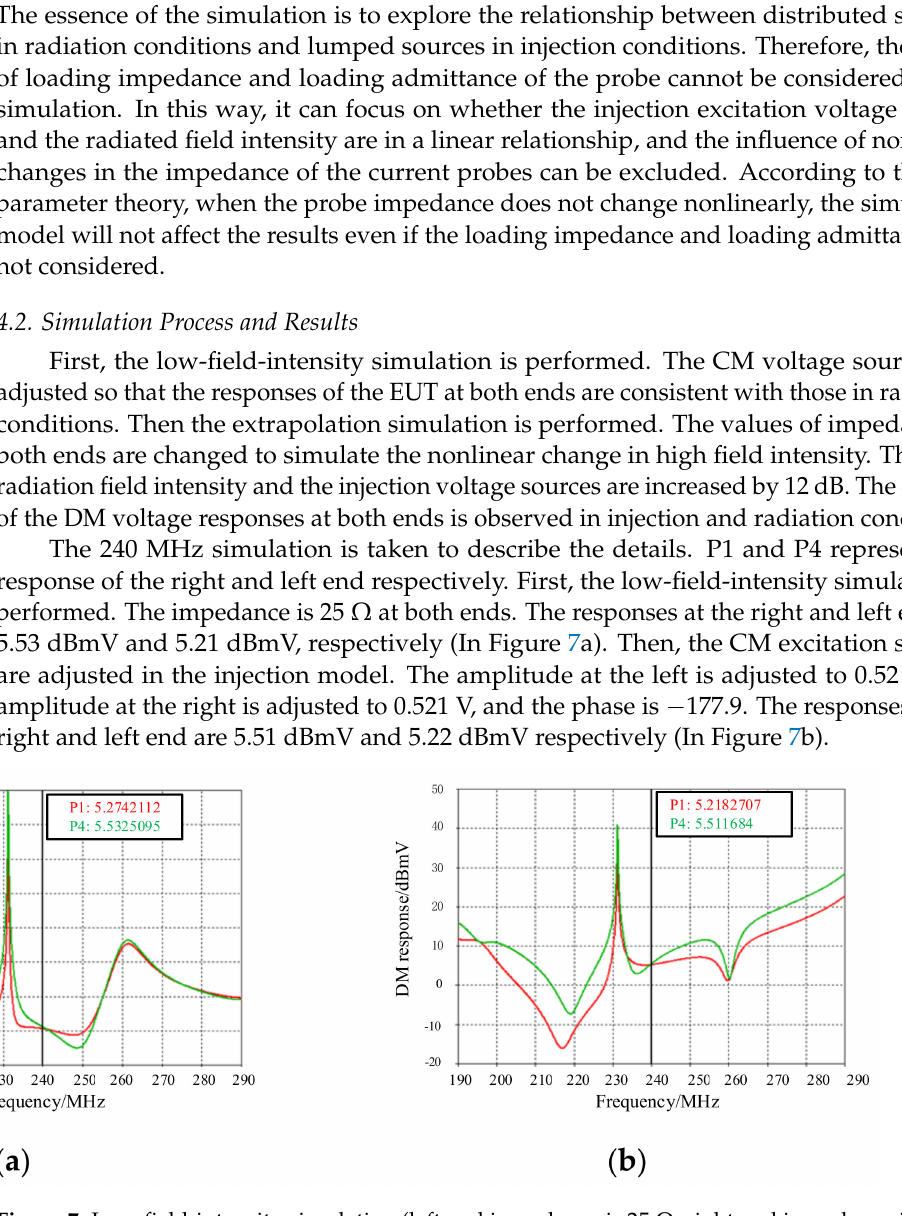
Figure 7. Low-field-intensity simulation (left end impedance is 25 Ω , right end impedance is 25 Ω ): ( a ) radiation; ( b )